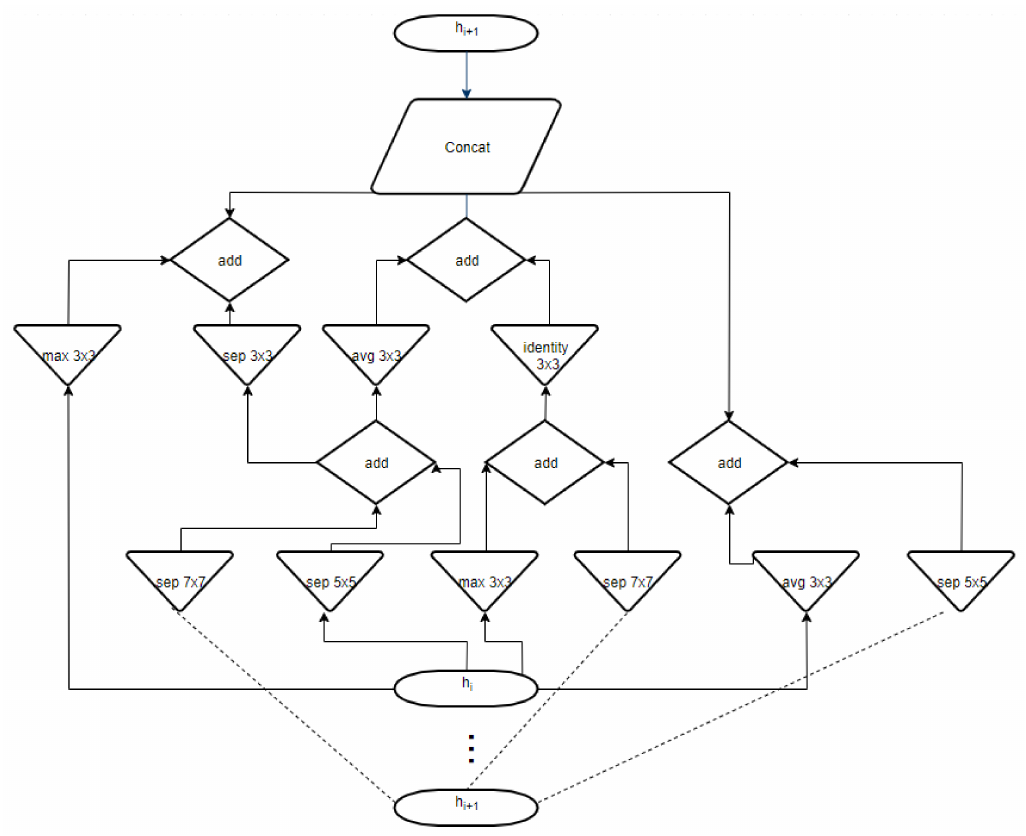
Figure 27. NasNet-Large CNN